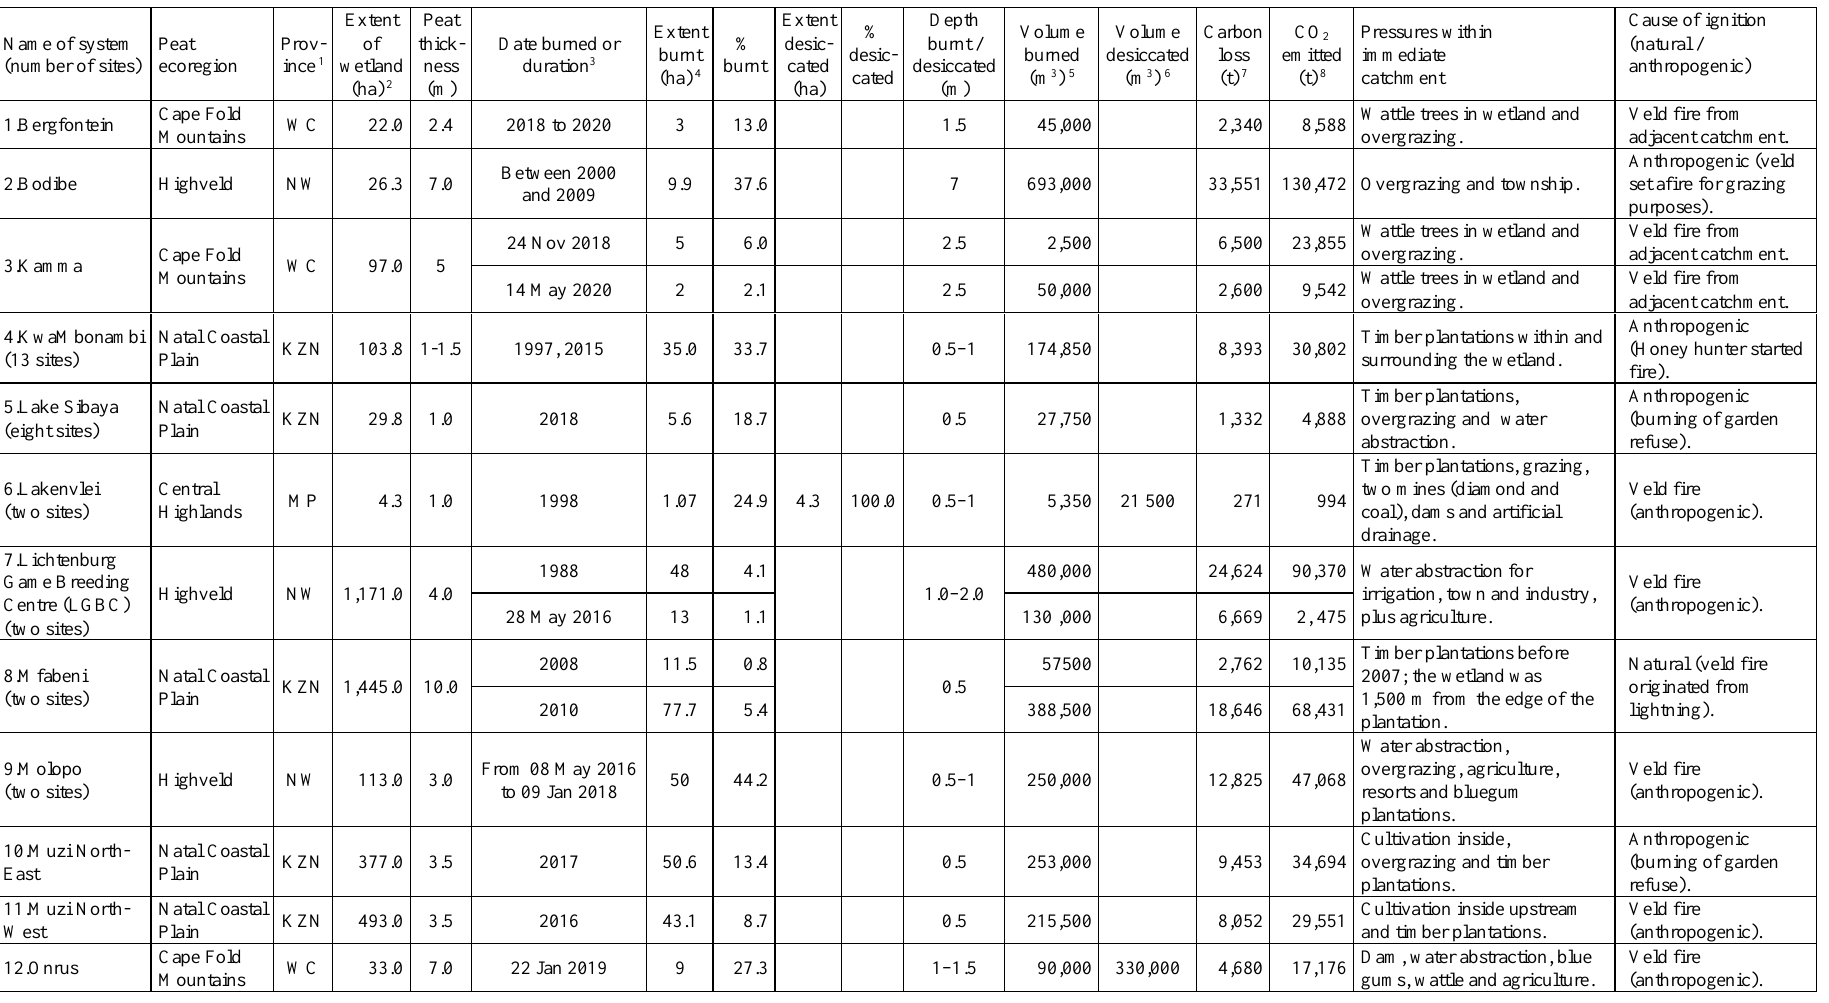
Table A2. Number and areal extent (ha) of peat fires observed between 1988 and May 2020 (see Figure 4). Name of system Peat (number of sites)